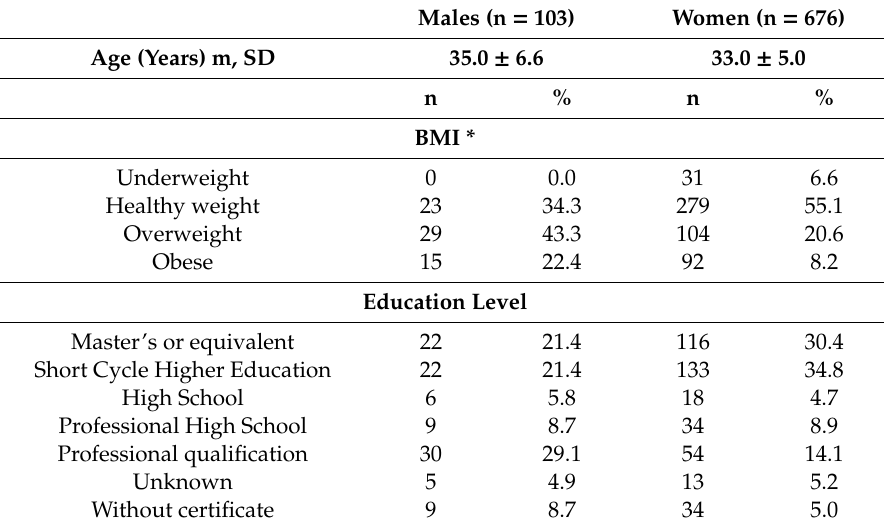
Table 1. Sociodemographic characteristics of the patients seen at the ARTEMIS Center from 16 February 2016 to 2 May 2019 (n = 779), according to